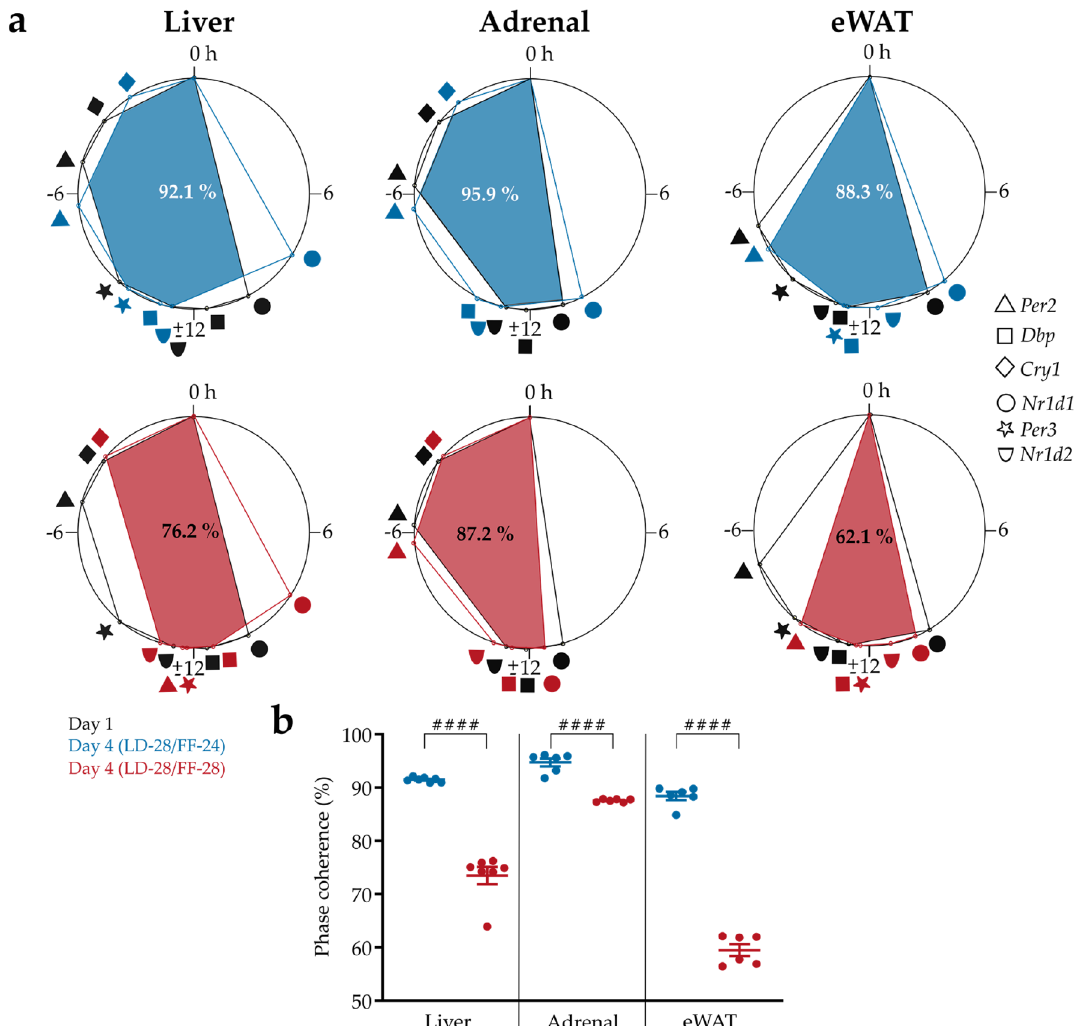
Figure 4. Feeding regimes differentially impact phase coherence within tissues. ( a ) Phase coherence of clock gene expression peaks within tissue on the first (black) and fourth day of the experiment under LD-28/FF-24 (blue) and LD-28/FF-28 (red) conditions. Representative overlaps (coloured areas) are shown for the peak of expression of Per2 (triangles), Dbp (squares), Cry1 (diamonds), Nr1d1 (circles), Per3 (stars), and Nr1d2 (semicircles) relative to Bmal1 expression peak (0 h). The area overlaps between day 1 and 4 of the respective FF condition are indicated in the overlapping area. Note, that Per3 was excluded from further analysis in adrenal since Per3 was not found to be rhythmic under LD-28/FF-28 conditions. ( b ) Phase coherence calculated from area overlap with each gene serving as reference gene. Data are shown as means ± SEM; n = 6–7; ### p < 0.001,